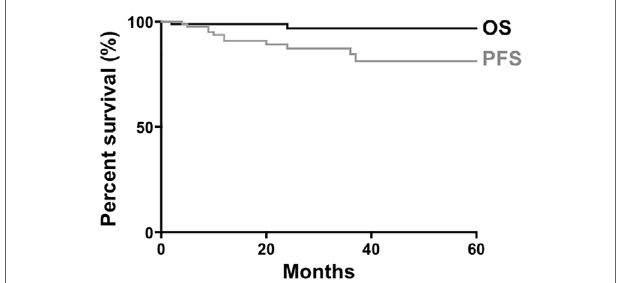
FiGURe 3 | Survival of patients with dural marginal zone lymphoma. Data from 93 patients were available for generation of curves for overall survival (OS) and progression-free survival